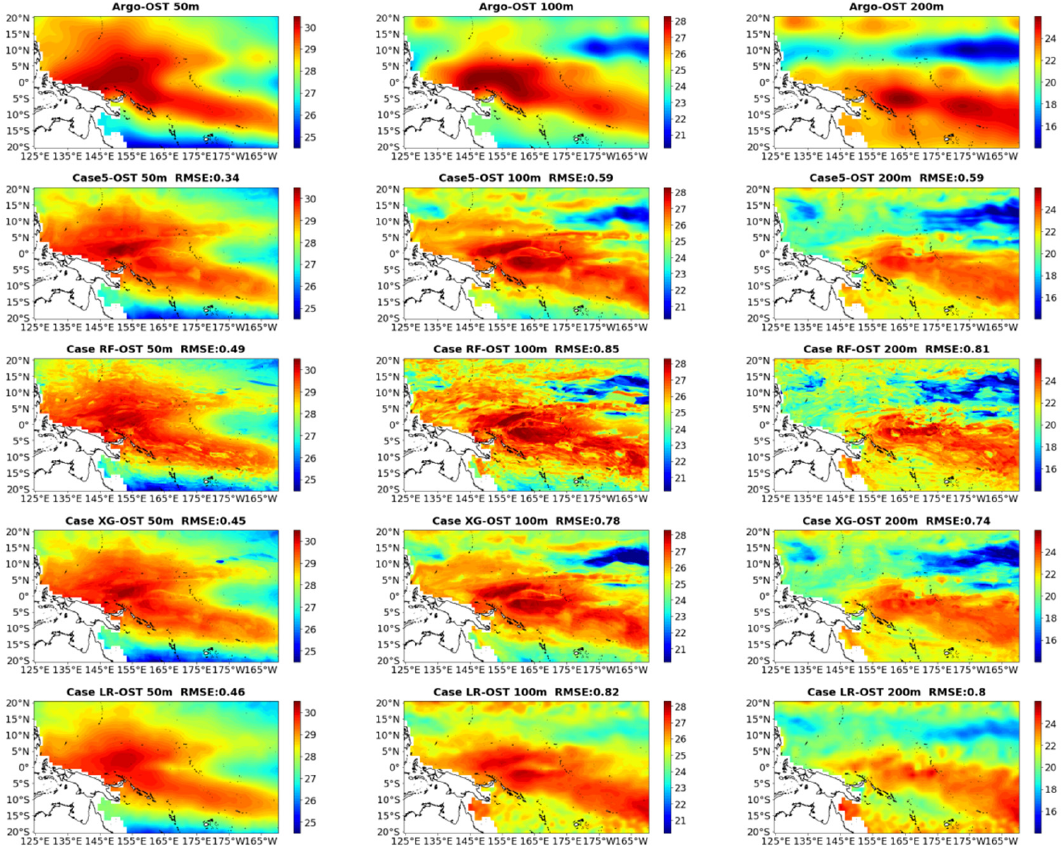
Figure 3. The OST for November 2016 of Argo data (first row), Case 5 (second row), Case RF (third row), Case XG (fourth row), and Case LR (fifth row). From left to right: 50 m, 100 m, and 200